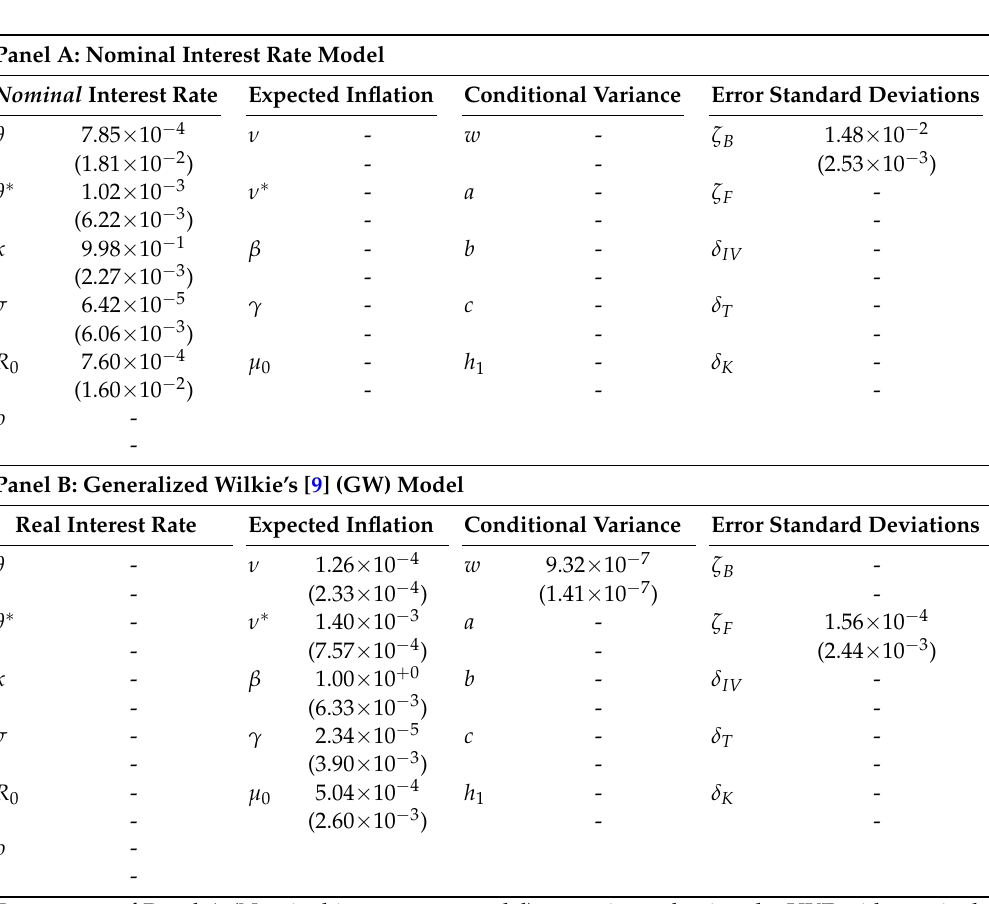
Table 5. Parameters estimates and standard errors for nested versions of the